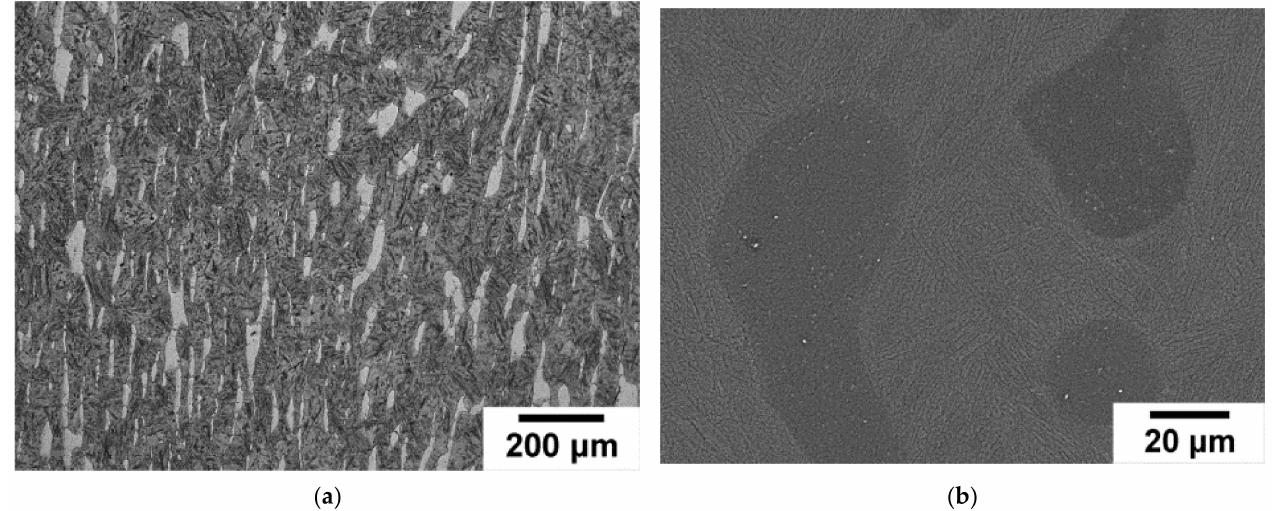
Figure 5. ( a ) Optical metallography and ( b ) SEM image of the structure of the 12% Cr steel after homogenization annealing at 1200 ◦ C for 16 h with following forging at 1200 ◦ C, air